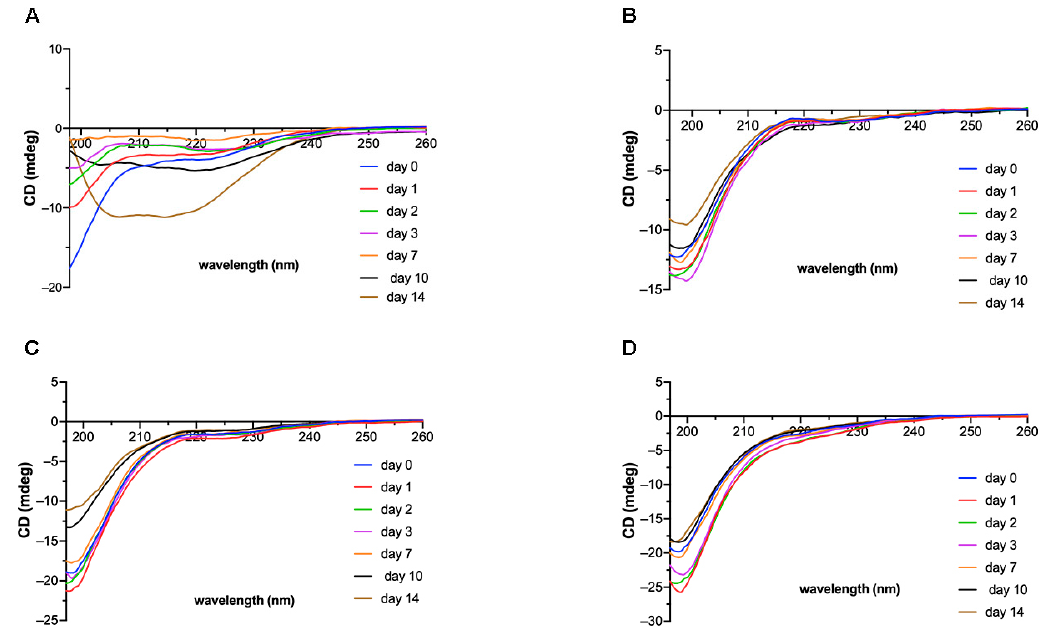
Figure 5. Circular dichroism (CD) spectra for the peptides ( A ) FC, ( B ) FC-GHK; ( C ) FC-KGHK and ( D ) FC-IM over 14 days incubation at a concentration of 1 mg/mL in PBS.